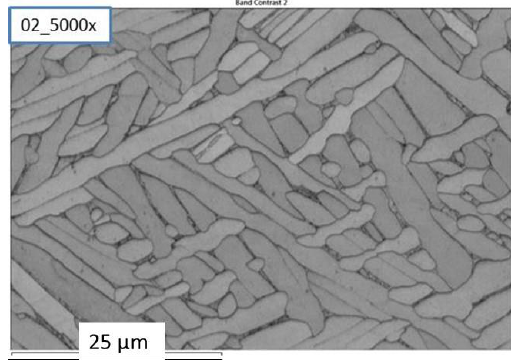
Figure 1. Microsctructure of Ti-6Al-4V showing α lamellae inmersed in β matrix. Depending on the cooling rate from the β transus temperature, different microstruc- WAAM is frequently linked with high anisotropy, that is, a difference between tures can be found in Ti-6Al-4V material. At very low cooling rates, α in the grain bound- mechanical properties determined along the building direction and transversally [10]. As aries ( α GB ) is first formed around prior β grains. After the formation of α GB , primary α shown in many previous works Ti-6Al-4V parts built by WAAM present large and is formed in parallel lamellae, forming colonies, oriented perpendicularly to the α GB . If elongated prior β gr ains oriented in the Z direction (growing direction) in the as-built the cooling rate is higher inside the β grains, primary alpha is formed in basket weave condition [11]. These grains are oriented in this way due to the thermal dissipation structure. At very high cooling rates (more than 525 ◦ C/s) non diffusional transformations occurs, forming martensite ( α ’) direction (Z), different strategies have been developed in several works. Application of